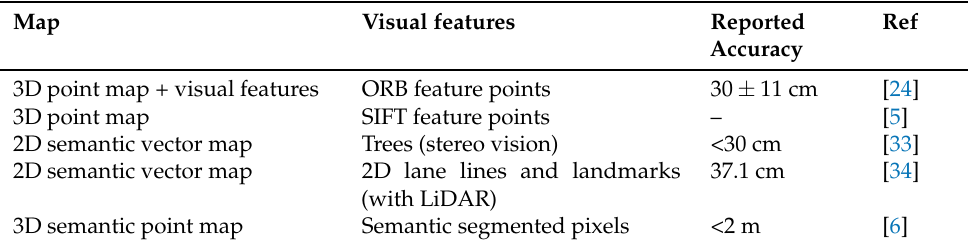
Table 1. Selected prior arts in HD map-based vehicle